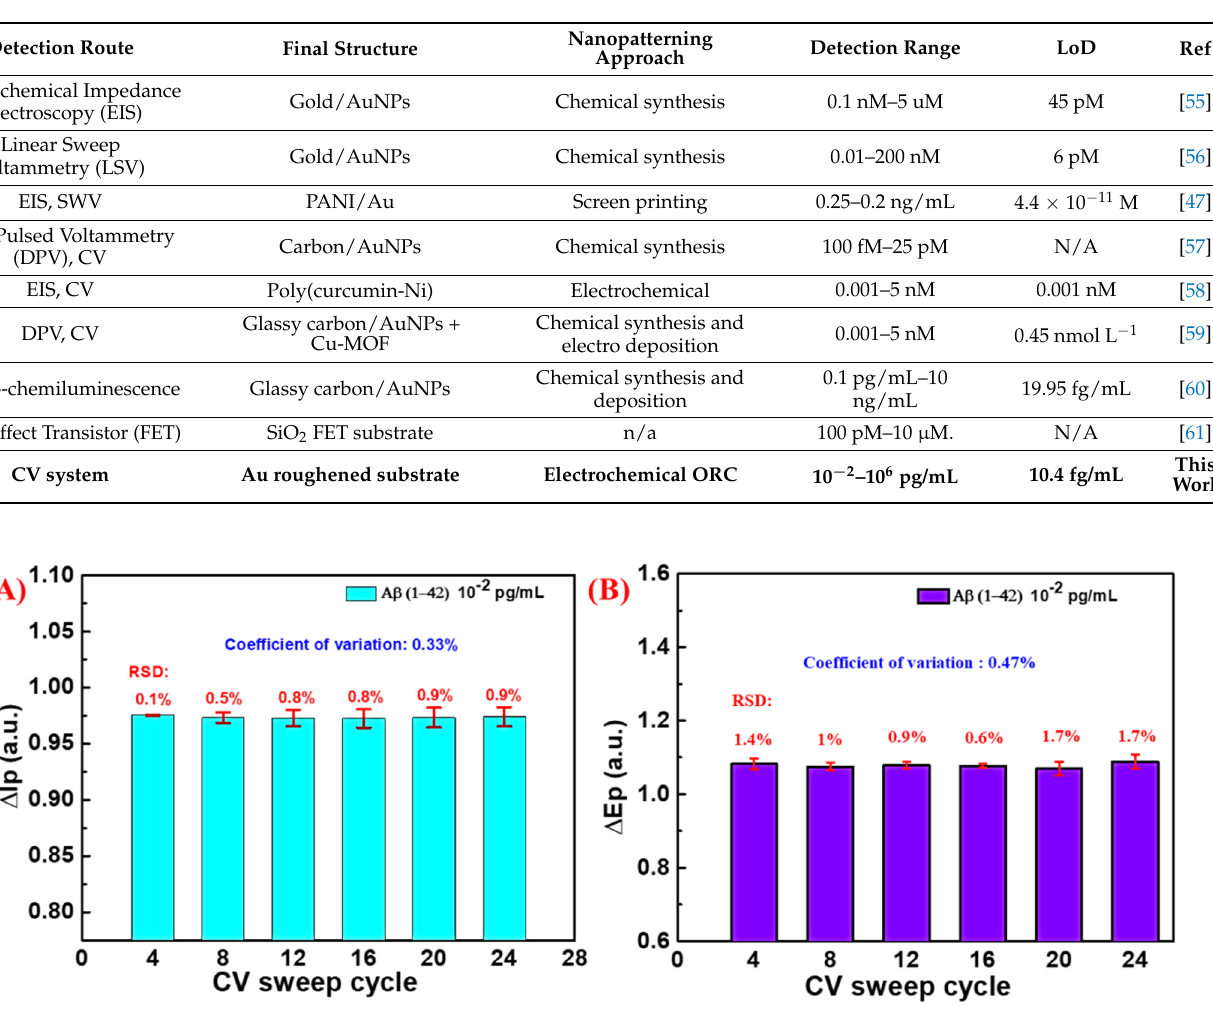
Figure 6. Stability of ( A ) ∆ I p and ( B ) ∆ E p of A β (1–42) peptide detection with 0.01 pg/mL concentration using three sensors at different cycle points run in CV between 0 and 0.4 V at a scan rate of 50 mV/s in 5 mM K 3 [Fe(CN) 6 ]/K 4 [Fe(CN) 6 ] and 0.5 M KCl using polished, and ORC treated gold sheet plate. Table 1. Performance and features comparison: previously published A β (1–42) sensor versus the proposed ORC modified Au substrate.